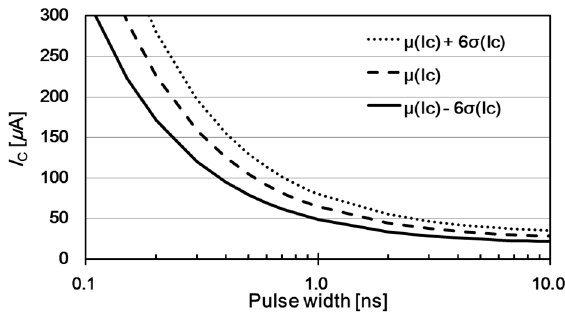
Figure 3. Critical switching current (I C ) of MTJ according to pulse width [10].